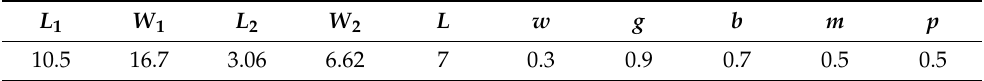
Table 1. The 6-bits U-shaped slot resonator structural parameters values (unit: mm).